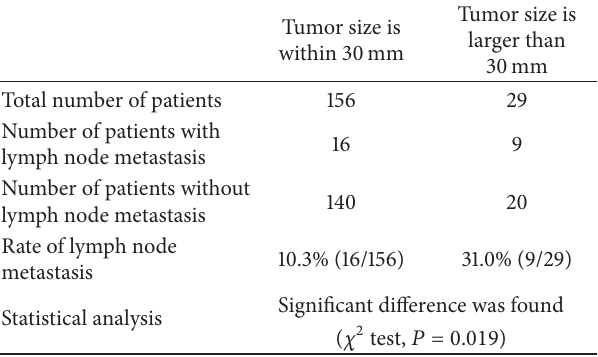
Table 4: Comparison of rate of lymph node metastasis in patients with gangliocytic paraganglioma focusing on tumor size (30